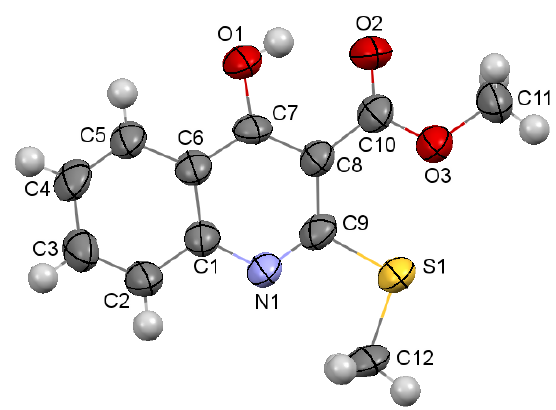
Figure 5. Molecular structure of compound 3 according to X-ray diffraction data. Thermal displacement ellipsoids are shown at the 50% probability level.